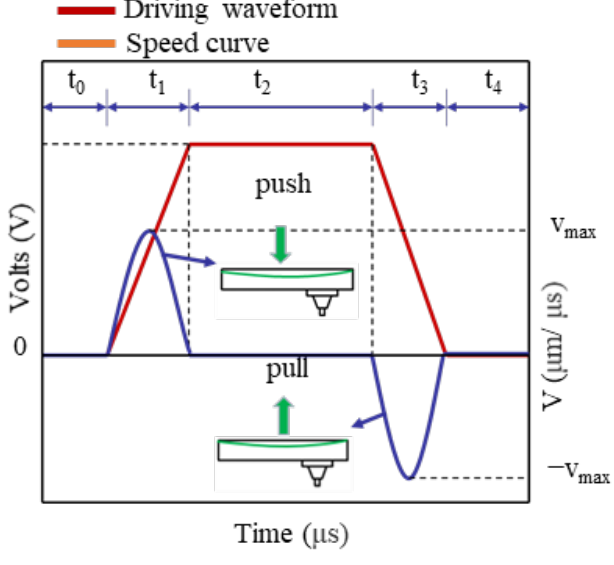
Figure 2. Driving pulse signal.